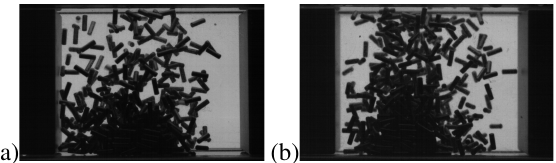
Figure 3. Exemplary experimental snapshots of front (a) and bottom (b) views showing 550 rods of (cid:96) = 3 mm length (filling fraction φ = 3%) with in-phase excitation ( ϕ = 0). A cluster of particles near one the container edges is observed, visually resembling the simulation results from Fig. 2. Experimental data were kindly provided by the SPACE GRAINS